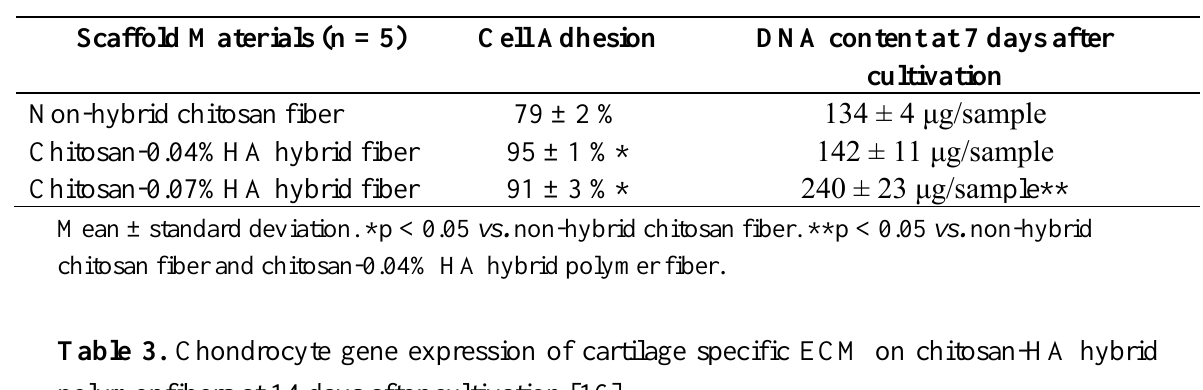
Table 3. Chondrocyte gene expression of cartilage specific ECM on chitosan-HA hybrid polymer fibers at 14 days after cultivation [16].